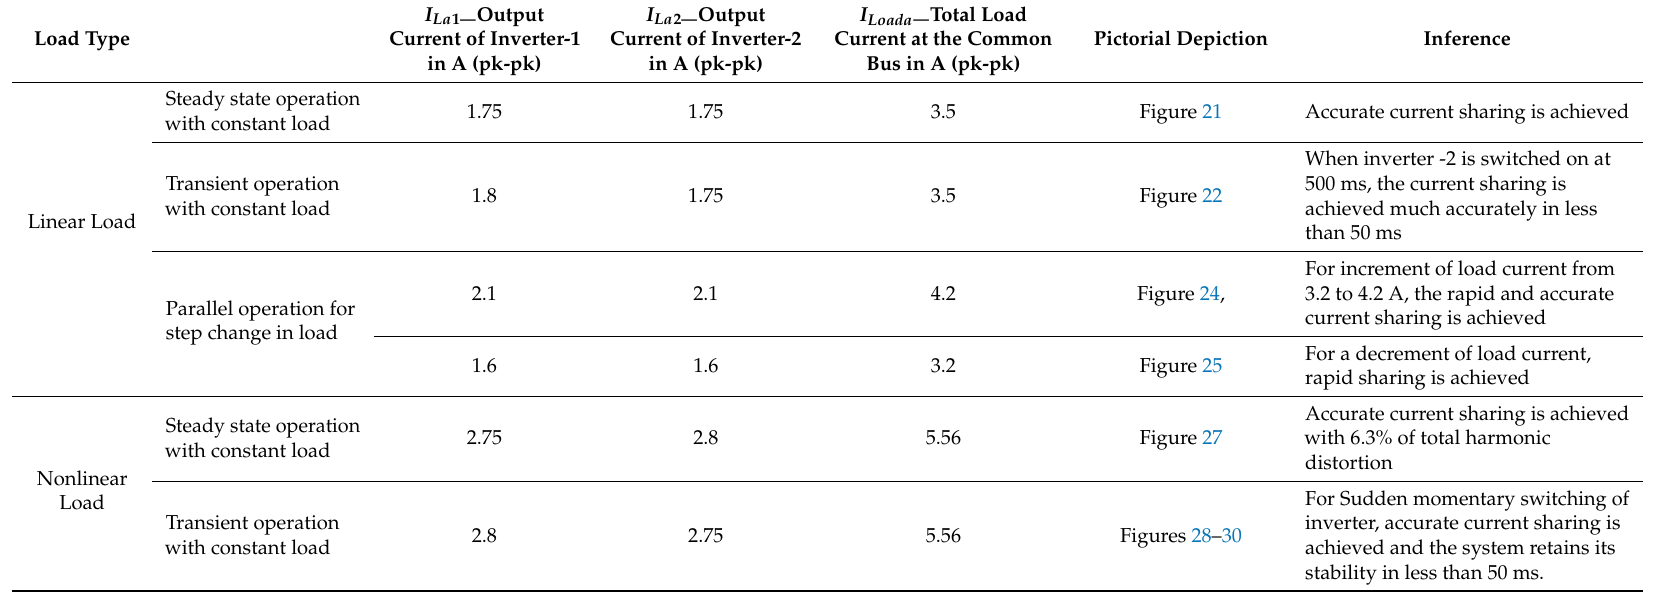
Table 2. Experimental result with figure